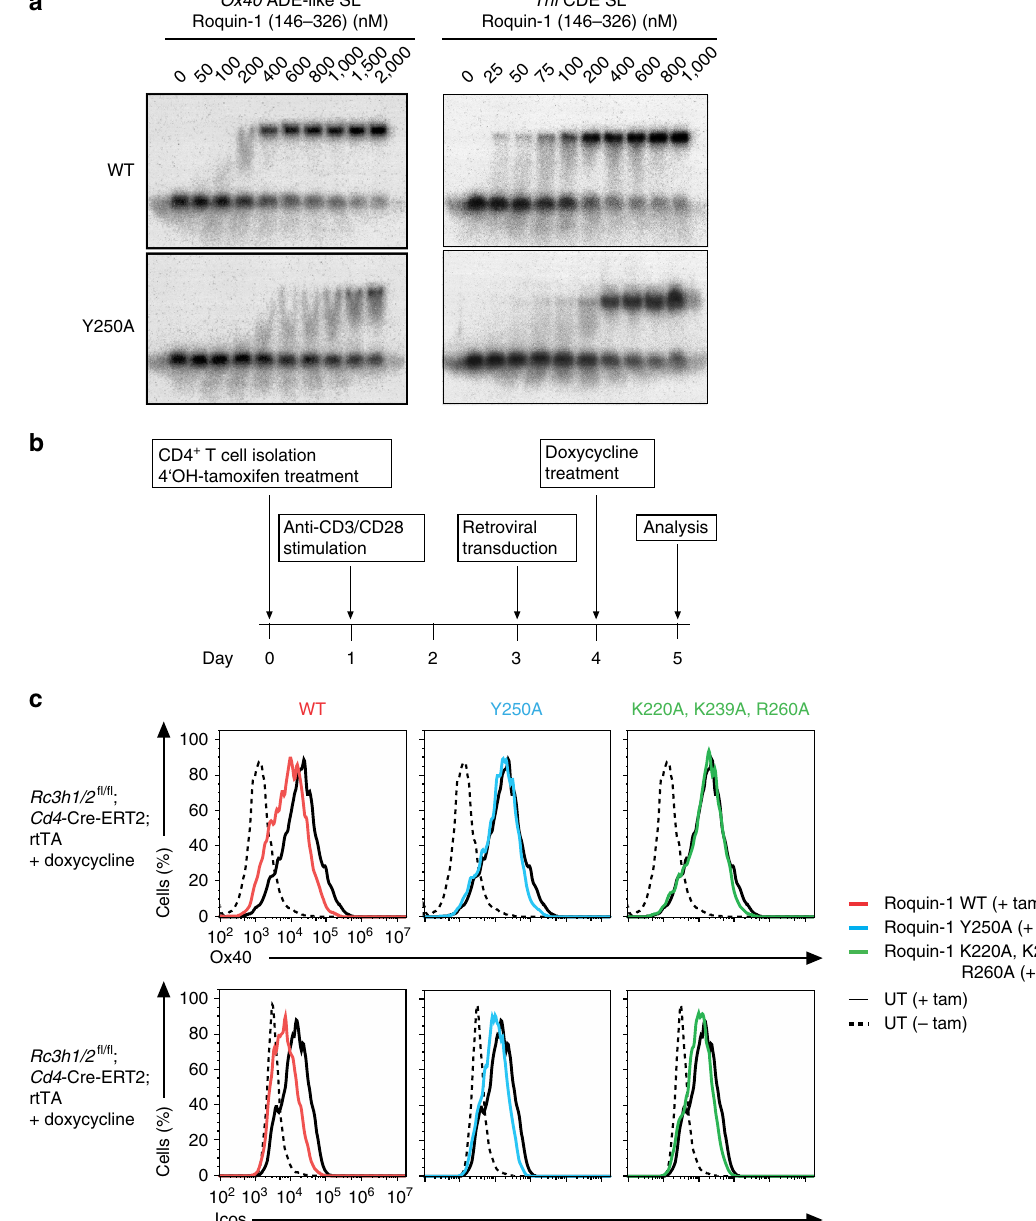
Figure 5 | Mutational analysis of Roquin-1-interactions with Ox40 ADE-like SL and Ox40 3 0 -UTR. ( a ) EMSA assay comparing binding of the wild-type and of the Y250A mutant ROQ domain for binding to the Ox40 ADE-like SL (left) or the previously described Tnf CDE SL (right). A comparison of further mutants is shown in Supplementary Fig. 4. ( b ) Schematic overview of the timeline used for the reconstitution experiment shown in c . ( c ) Flow cytometry of Ox40 and Icos surface expression on CD4 þ T h 1 cells from Rc3h1/2 fl/fl ; Cd4 -Cre-ERT2; rtTA mice treated with tamoxifen ( þ tam) to induce Rc3h1/2 fl/fl deletion or left untreated ( (cid:3) tam). The cells were then either left untransduced (UT) or were transduced with retrovirus containing a doxycycline-inducible cassette, to express Roquin-1 WT, Roquin-1 Y250A or Roquin-1 K220A, K239A and R260A mutants (see also Supplementary Fig.